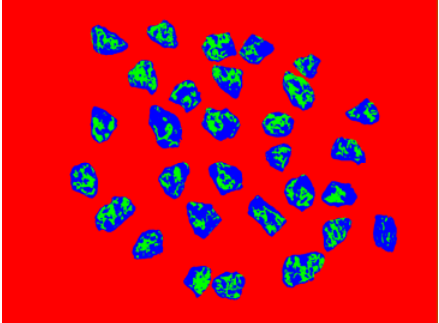
Figure 10: Classification image with background (red), uncovered aggregate (blue) and bitumen